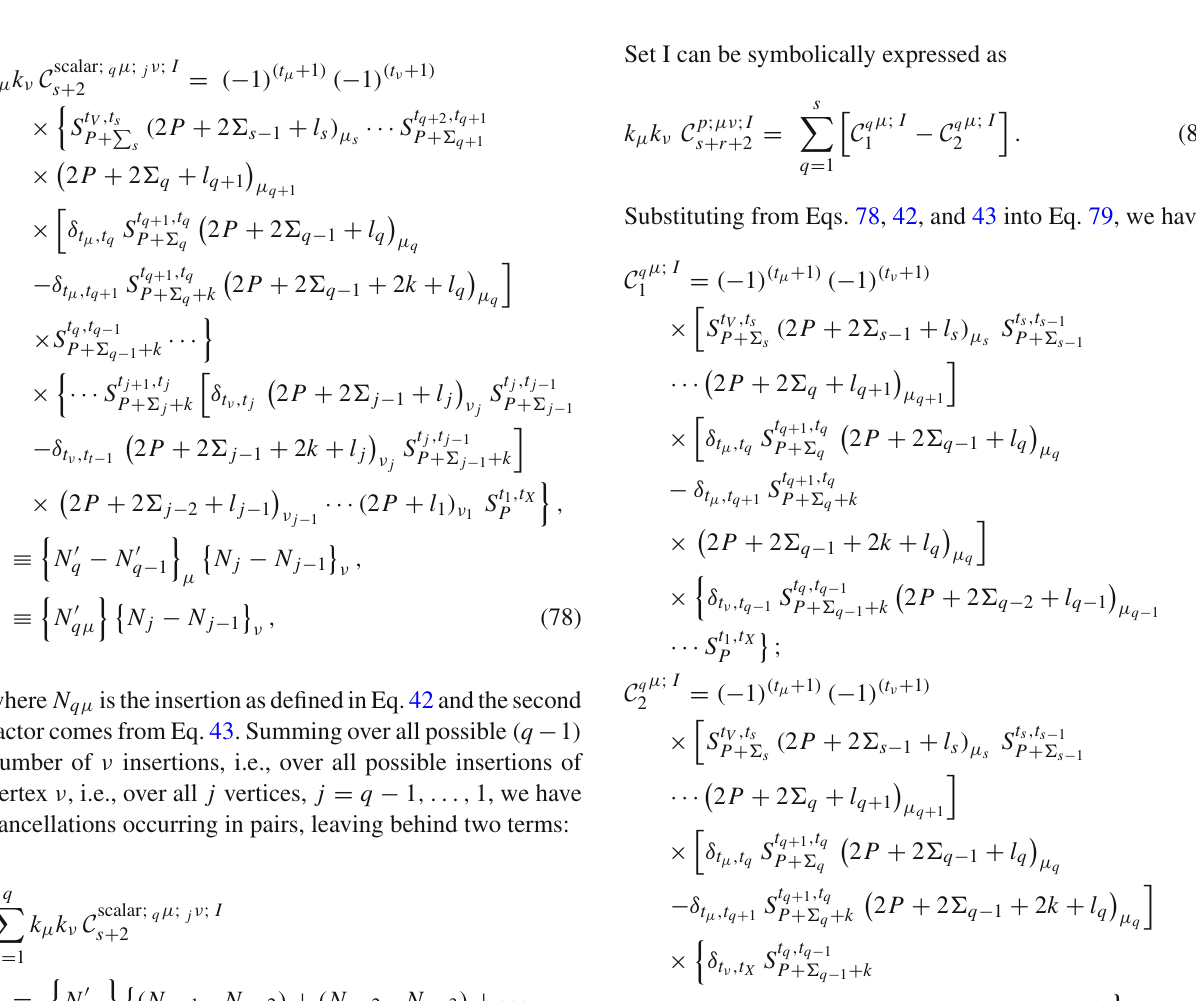
Fig. 13 Typical diagrams contributing to insertions of both vertices μ and ν on the intermediate scalar (dashed) line. Top-left: Set I, top-right: Set II, bottom-left: Set III, bottom-right: Set IV. The p (cid:6) leg remains unaffected by the insertions and hence is not shown. See text for